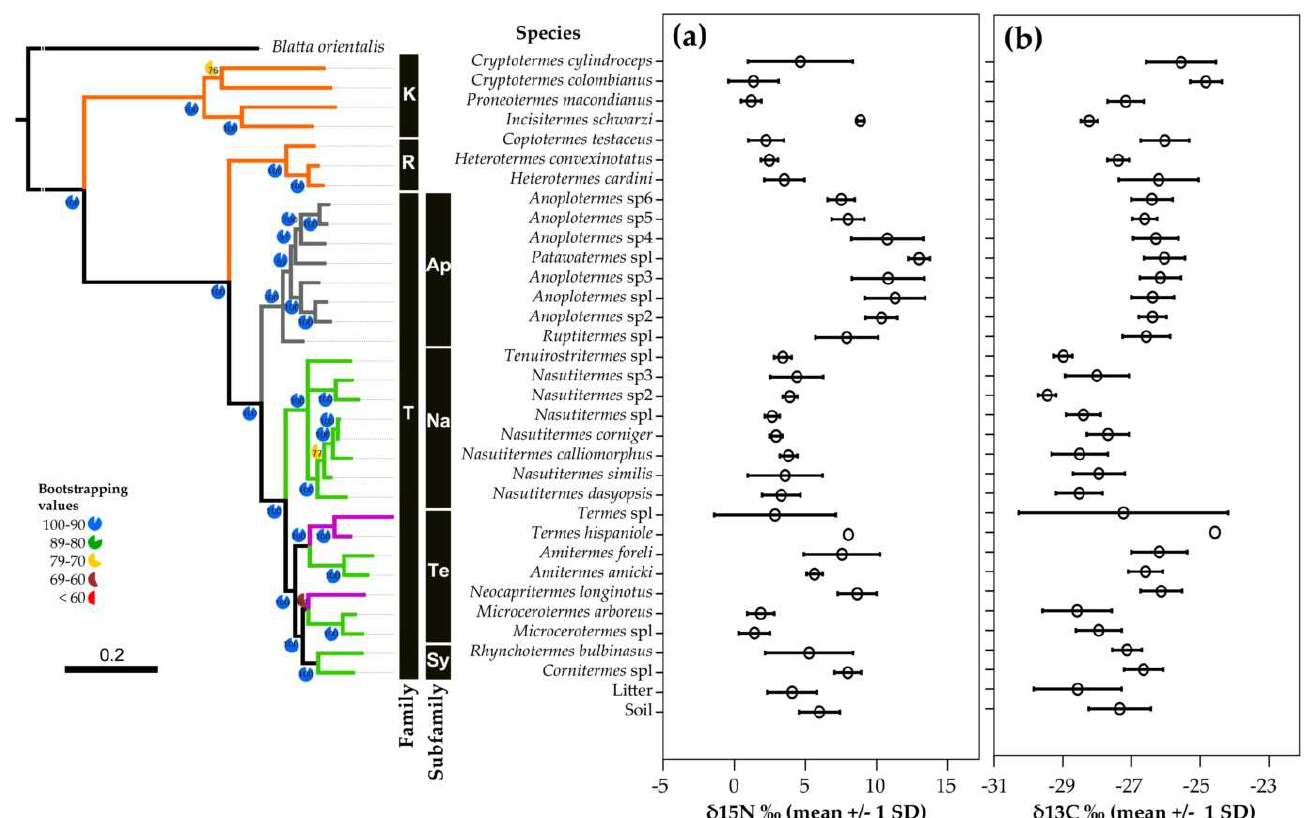
Figure 6. Phylogenetic relationships between the studied termites and their associated δ 15 N and δ 13 C signatures, together with that of litter and soil. Bootstrap values close to nodes. ( a ) Shown are bars with mean for δ 15 N‰ +/− 1 SD over all three study sites. ( b ) Bars with mean for δ 13 C‰ +/− 1 SD over all three study sites. Orange: Feeding group I, Green: Feeding Group II, Purple: Feeding group III, Grey: Feeding group IV. Families: K: Kalotermitidae, R: Rhinotermitidae, and T: Termitidae. Subfamilies: Ap: Apicotermitinae, Na: Nasutitermitinae, Te: Termitinae, and Sy: Syntermitinae.